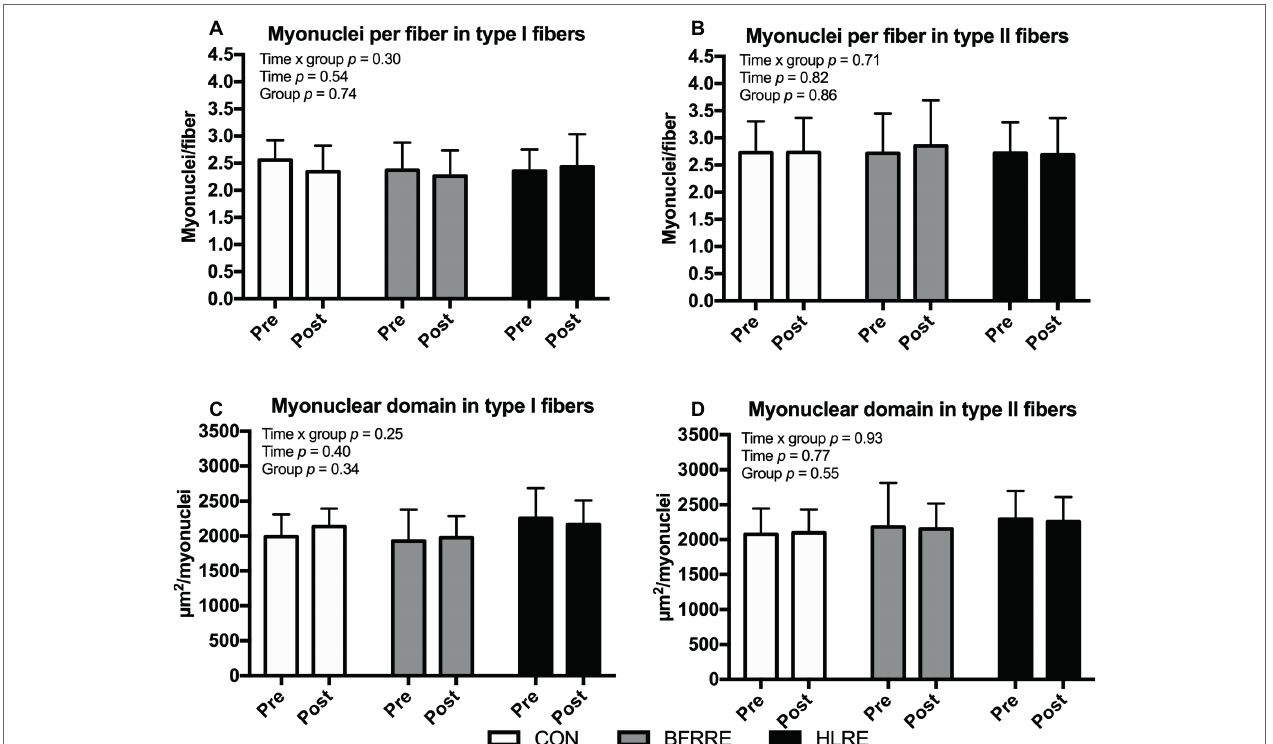
FIGURE 7 | Myonuclei at baseline (pre) and 4 days after cessation of training (post) expressed relative to number of fibers (A,B) and as myonuclear domain (C,D) . Data are presented as mean ± SD. Overall effects are given in the upper left corner of graphs.